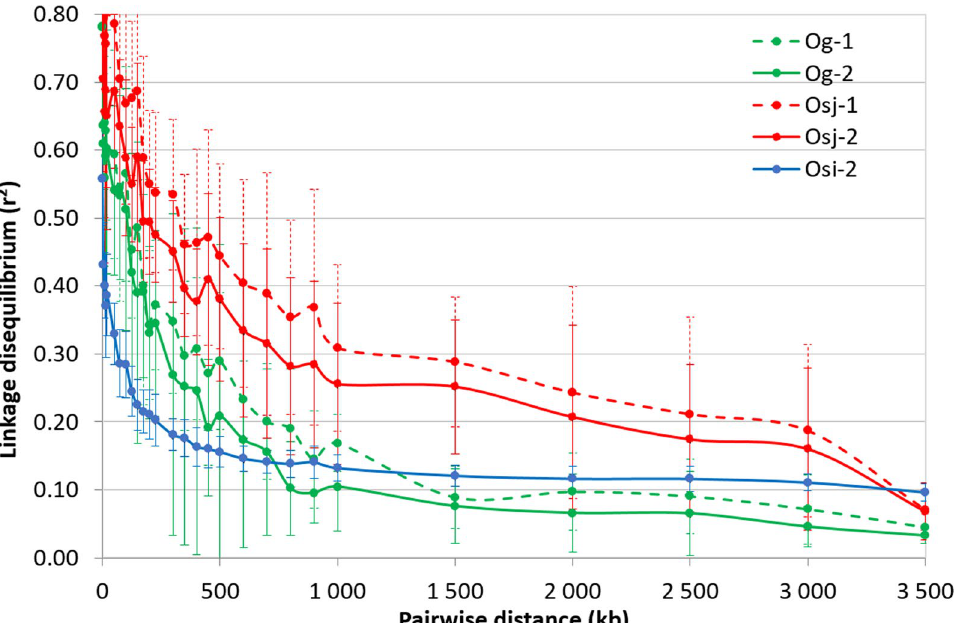
Fig. 5 Patterns of decay in the r 2 estimate of linkage disequilibrium (LD), in the rice populations collected in 1980 (xx-1) and in 2011 (xx-2); Og -1 and Og -2: O. glaberrima ; Osj -1 and Osj -2: O. sativa japonica ; Osi -2, O. sativa indica . The LD was estimated from 6250 SNP, 9282 SNP and 14,775 SNP loci for Og , Osj and Osi populations, respectively. The curve represents the average r 2 according to pairwise distance between markers among the 12 chromosomes and the bars represent the associated standard